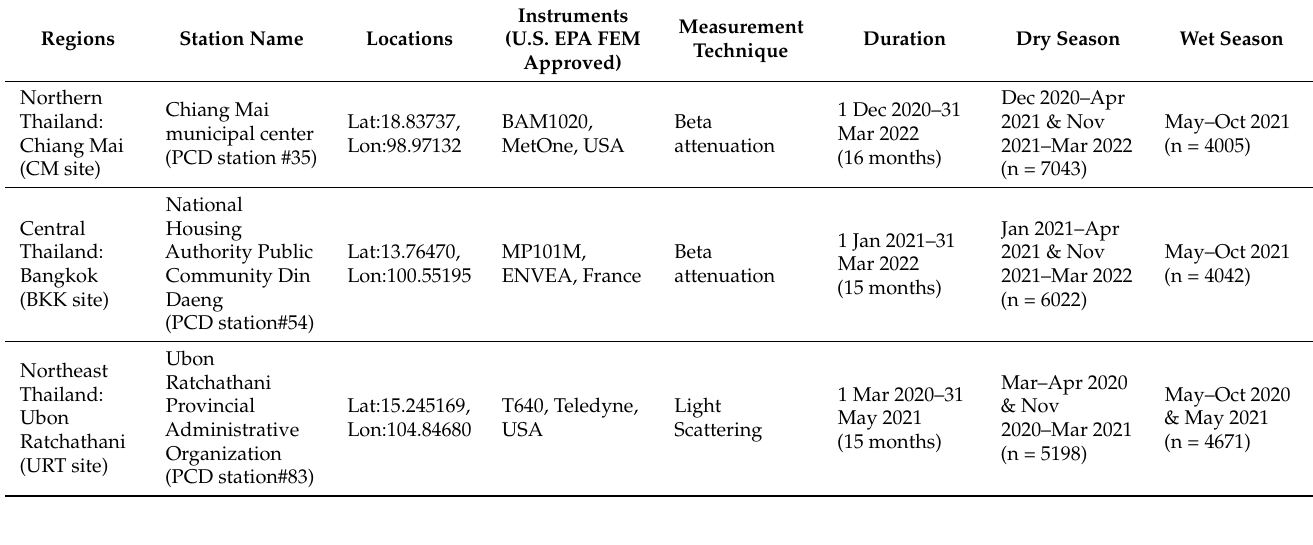
Table 1. Sampling locations, periods, and FEM instruments at three monitoring stations.